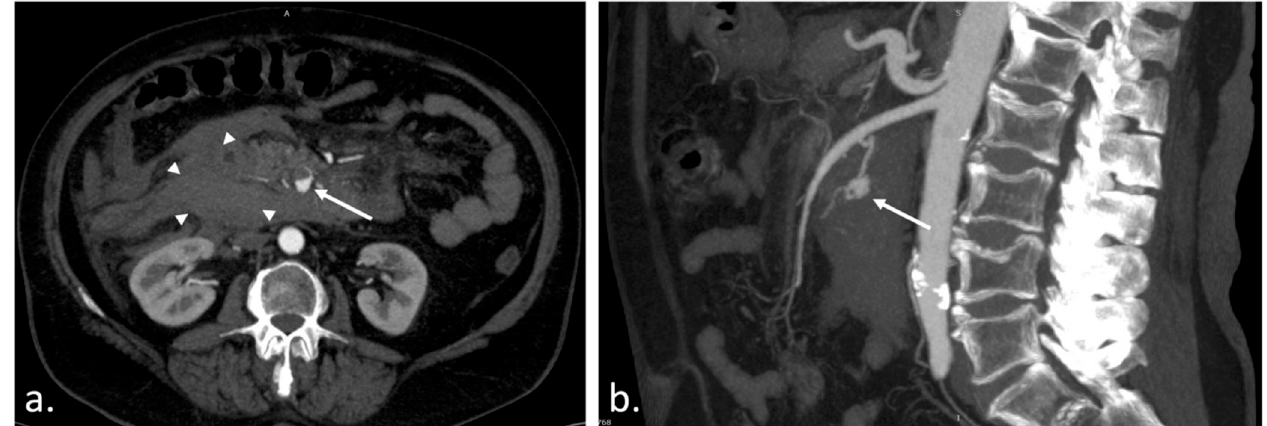
Figure 1. Aneurysmal dilatation of visceral arteries occurs in less than 1% of arterial aneurysm cases [1,2], primarily affecting the splenic artery, hepatic artery, and superior mesenteric artery; in only 1–2% of visceral aneurysms, it is found in the pancreaticoduodenal or gastroduodenal artery [1], with a high mortality rate in untreated cases [2–4]. Arterial aneurysmal dilatation develops as a result of damage to the collagen structure at the arterial wall caused by atherosclerosis or hypertension, and is found with the highest incidence at the level of the abdominal aorta [5–9]. In contrast, arterial pseudoaneurysms are connected with trauma, surgical treatments, or the presence of malignancies, but in the case of the pancreaticoduodenal artery, the main reason is the association with chronic pancreatitis [9–16]. Although it is a rare pathology, it is lethal in the absence of intervention. Endovascular treatment is currently the primary approach in the event of these pathologies, with a high success rate and excellent patient progression [4,9,13–23]. A 67-year-old woman presented with lightheadedness, diaphoresis, and acute epigastric and right hypochondrium pain. Along with other antecedents, her past medical history includes stage 2 essential hypertension, chronic ischemic cardiomyopathy, and class 1 obesity. Furthermore, three weeks before her current admission, she experienced a SARS-CoV-2 infection. She has no history of alcohol abuse, smoking, or abdominal trauma. An abdominal contrast-enhanced CT scan showed an extensive hematoma (3 × 4 cm 2 in size) located intra-abdominally, adjacent to the duodenojejunal area, with hyperdensity around the duodenum and inferior to the pancreas (30–59 HU). Moreover, the CT scan also revealed an enhancing lesion as a pseudoaneurysm of the inferior pancreaticoduodenal artery measuring 5 × 8 × 8 mm 3 with active bleeding and an associated hematoma. Additionally, the pancreas showed multiple hyperdense hemorrhagic structures anteriorly and superiorly under the aspect of possible acute hemorrhagic-ulcerative pancreatitis. Following these investigations of the abdominal area, a decision was made to proceed with an endovascular intervention within the interventional radiology department. ( a ) Transverse CT angiogram image shows a 12 mm enhancing lesion (white arrow) and a large intraperitoneal hematoma (arrowheads); ( b ) Sagittal MIP image depicts the enhancing lesion as a pseudoaneurysm (white arrow) of the inferior pancreaticoduodenal artery, responsible for the bleeding.